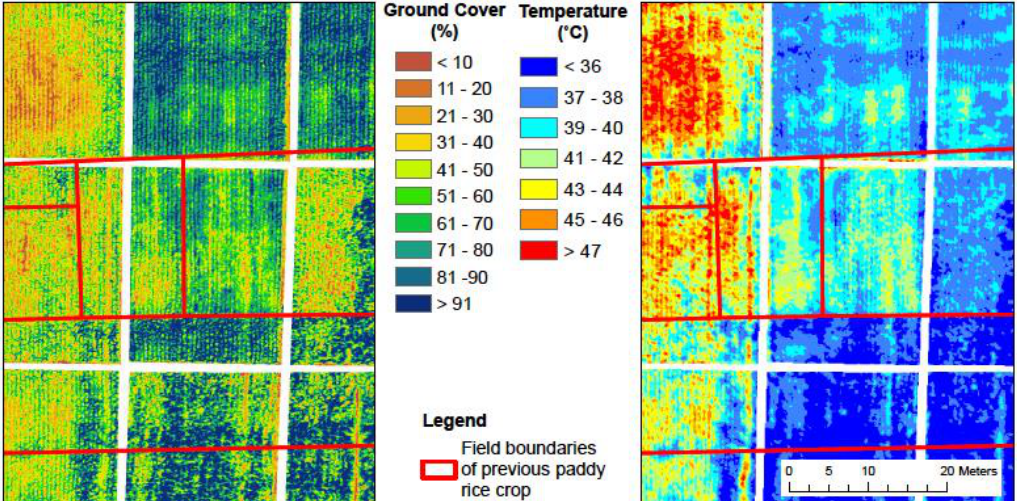
Figure 6. Plots of irrigation experiment near Patuakhali, Bangladesh, in 2015. The nine maize plots had been imposed over several farmers’ fields. The hard pans of some of the fields, created for the previous paddy rice crop, were not broken up when preparing the land for the maize experiment. This can be seen for the central plot, where plants suffered from dry conditions in the upper part, resulting in lower ground cover and higher canopy temperature as compared to the lower part of the plot.